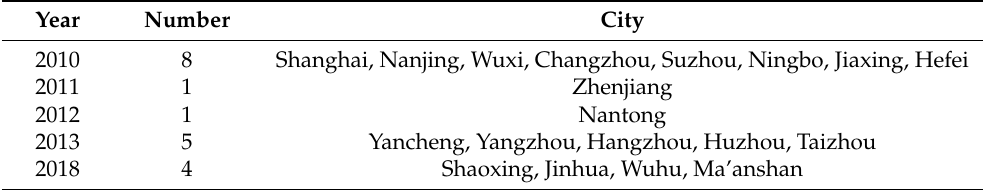
Table A1. Pilot year and city during 2001–2020 in the Yangtze River Delta urban